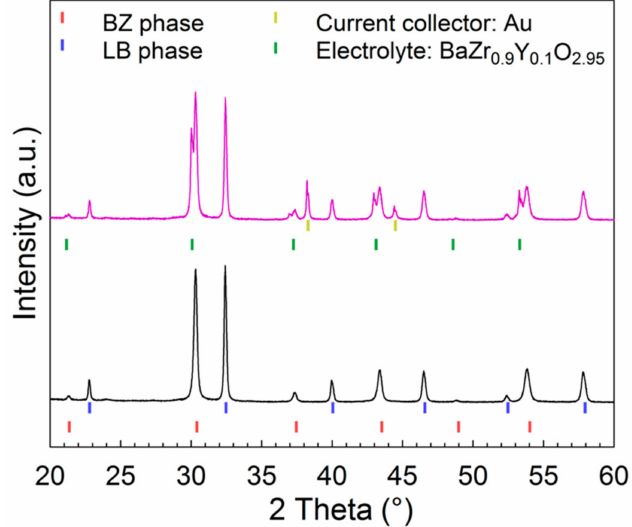
Figure 9. XRD patterns of the 3M10Y composite with nominal composition of 0.6 La 0.5 Ba 0.5 Co 1/3 Mn 1/3 Fe 1/3 O 3 − δ -0.4 BaZr 0.9 Y 0.1 O 2.95 . The black pattern represents the composite powder formed at 1000 ◦ C and the purple pattern represents the cathode deposited on the BaZr 0.9 Y 0.1 O 2.95 electrolyte after EIS characterization. Gold current collector reflections can be seen in the symmetric cell